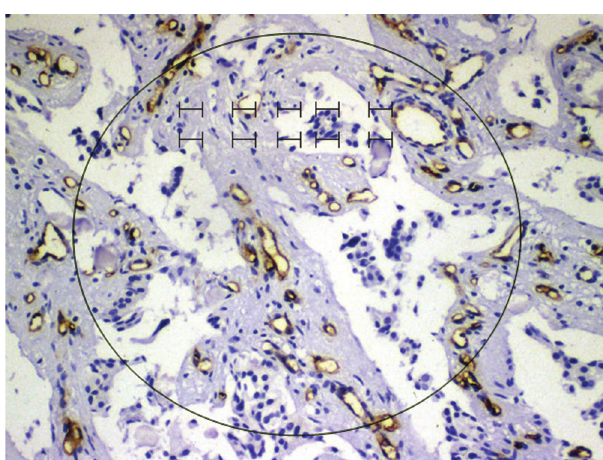
Figure 1 - Vessel counting using reticulum identification.